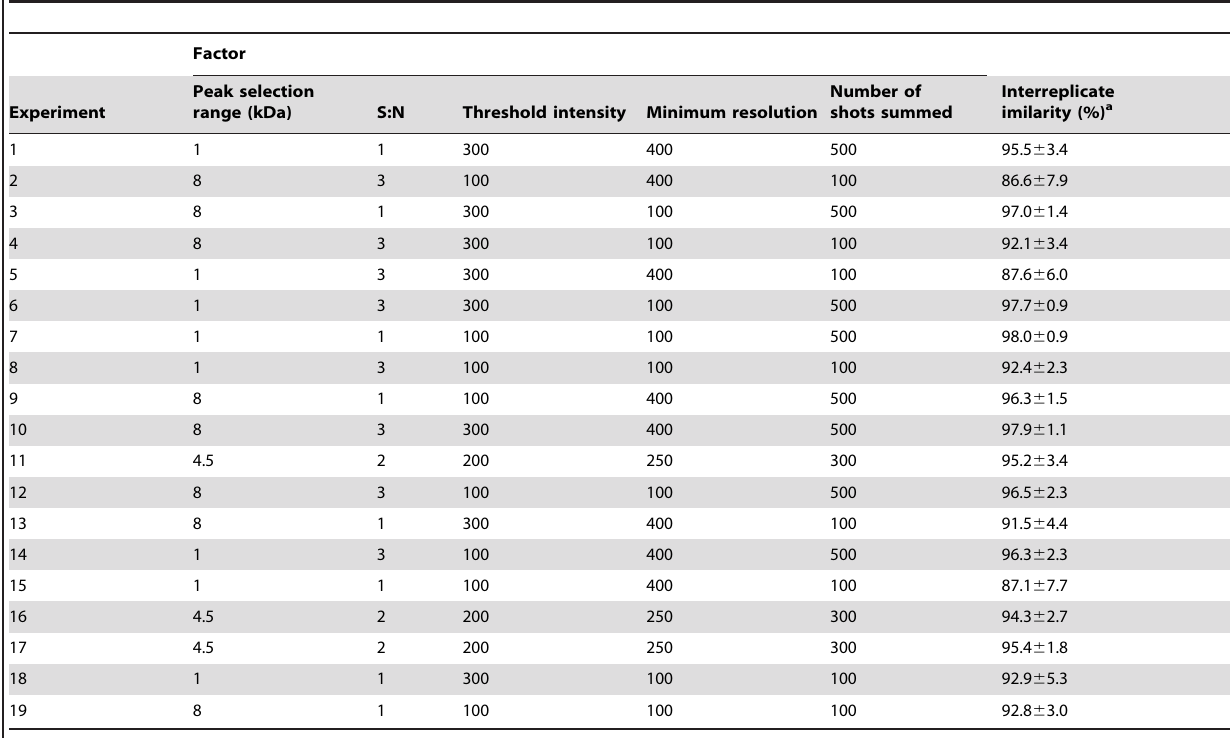
Table 2. Experimental design matrix of the fractional factorial designs and the resulting reproducibility of mass